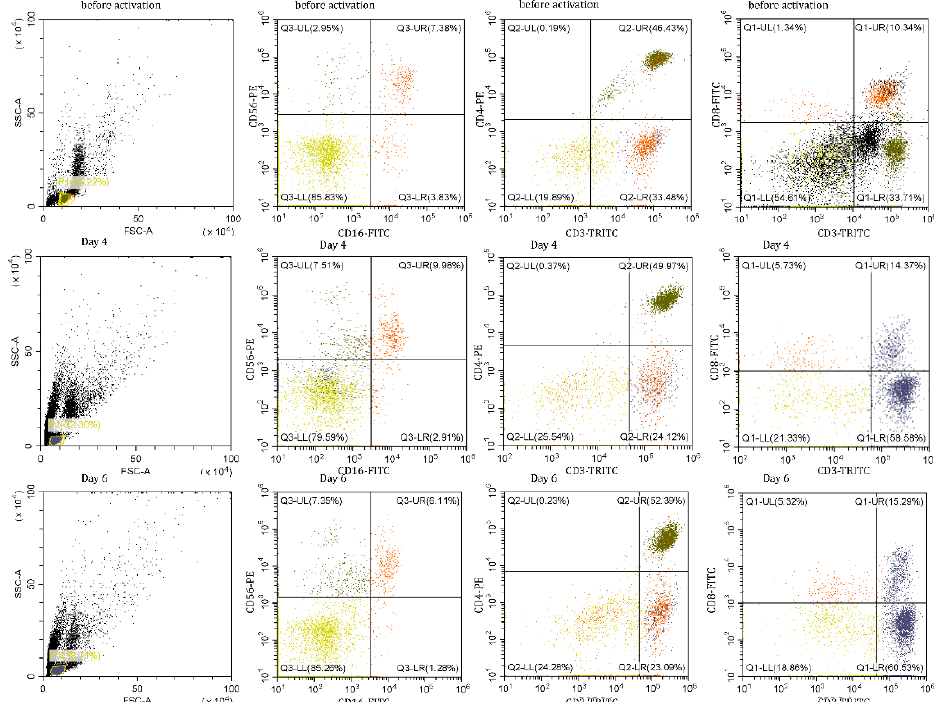
Figure 5. Ratios of lymphocyte subpopulations in PBMCs after N3 treatment.